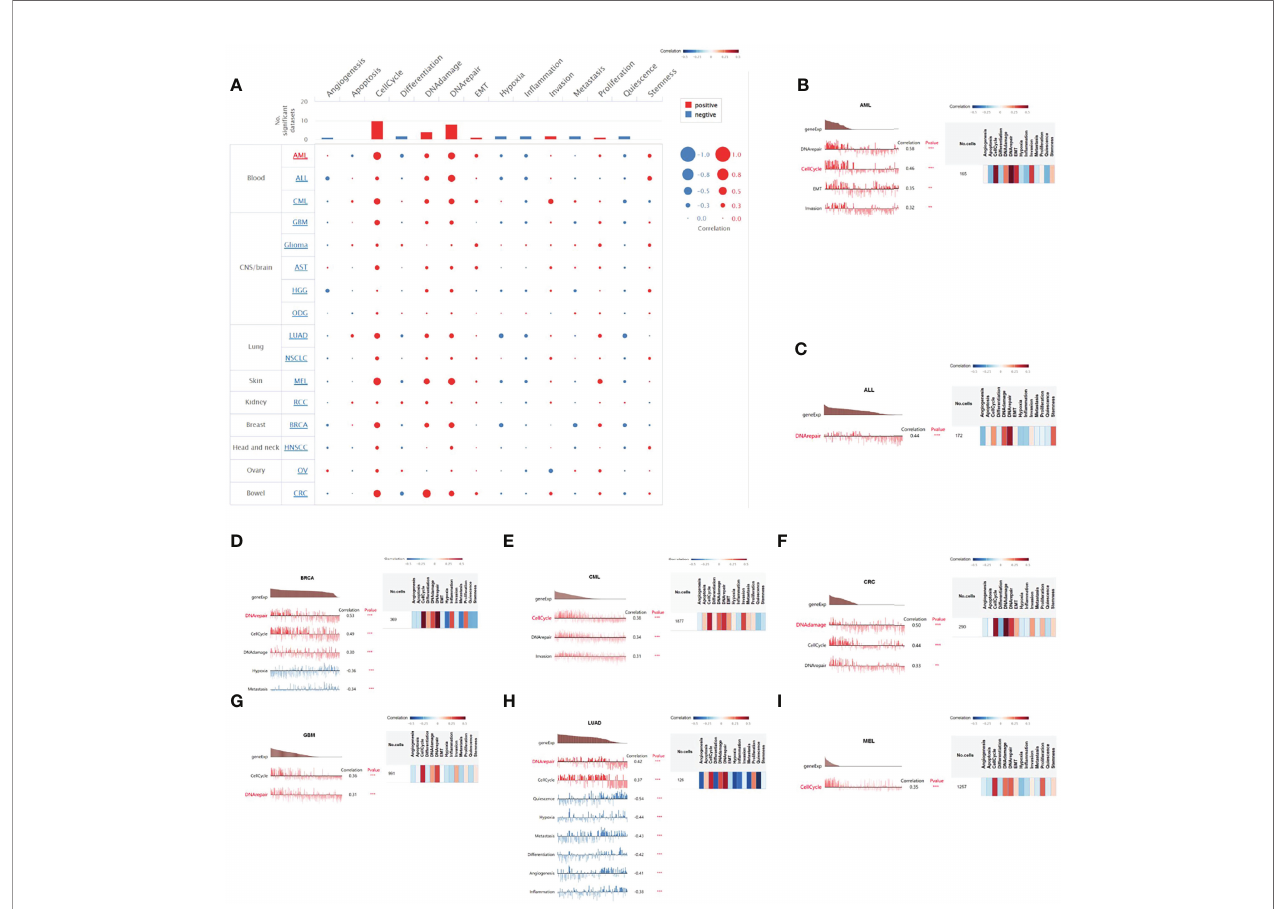
FIGURE 11 | The correlation of HELLS with functional state in cancers. (A) The interactive bubble chart present correlation of HELLS with functional state in 16 cancers. The correlation of HELLS with functional state in (B) AML, (C) ALL, (D) BRCA, (E) CML, (F) CRC, (G) GBM, (H) LUAD, (I) MEL. X-axis represents different gene sets; ***p < 0.001, **p < 0.01, *p <